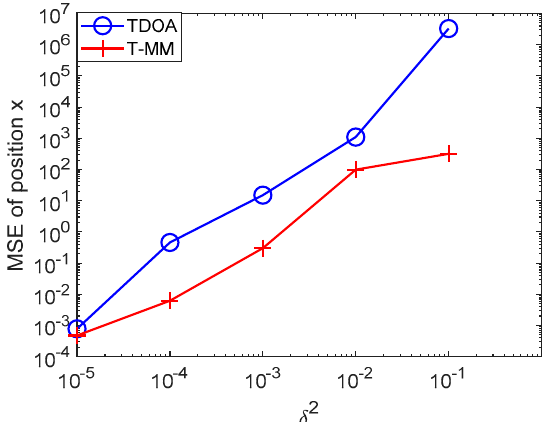
Figure 4. Mean square error (MSE) comparison between conventional TDOA and the proposed TDOA-majorization-minimization (T-MM) versus δ 2 .